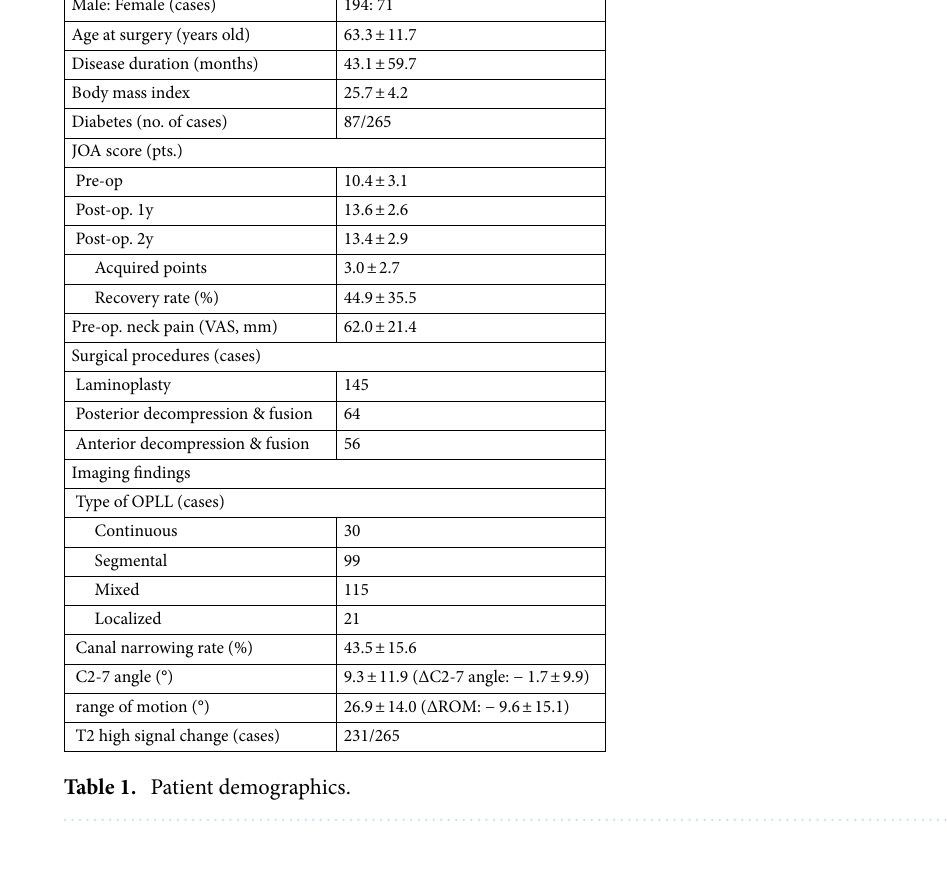
Neck pain (VAS, 0-100 mm)